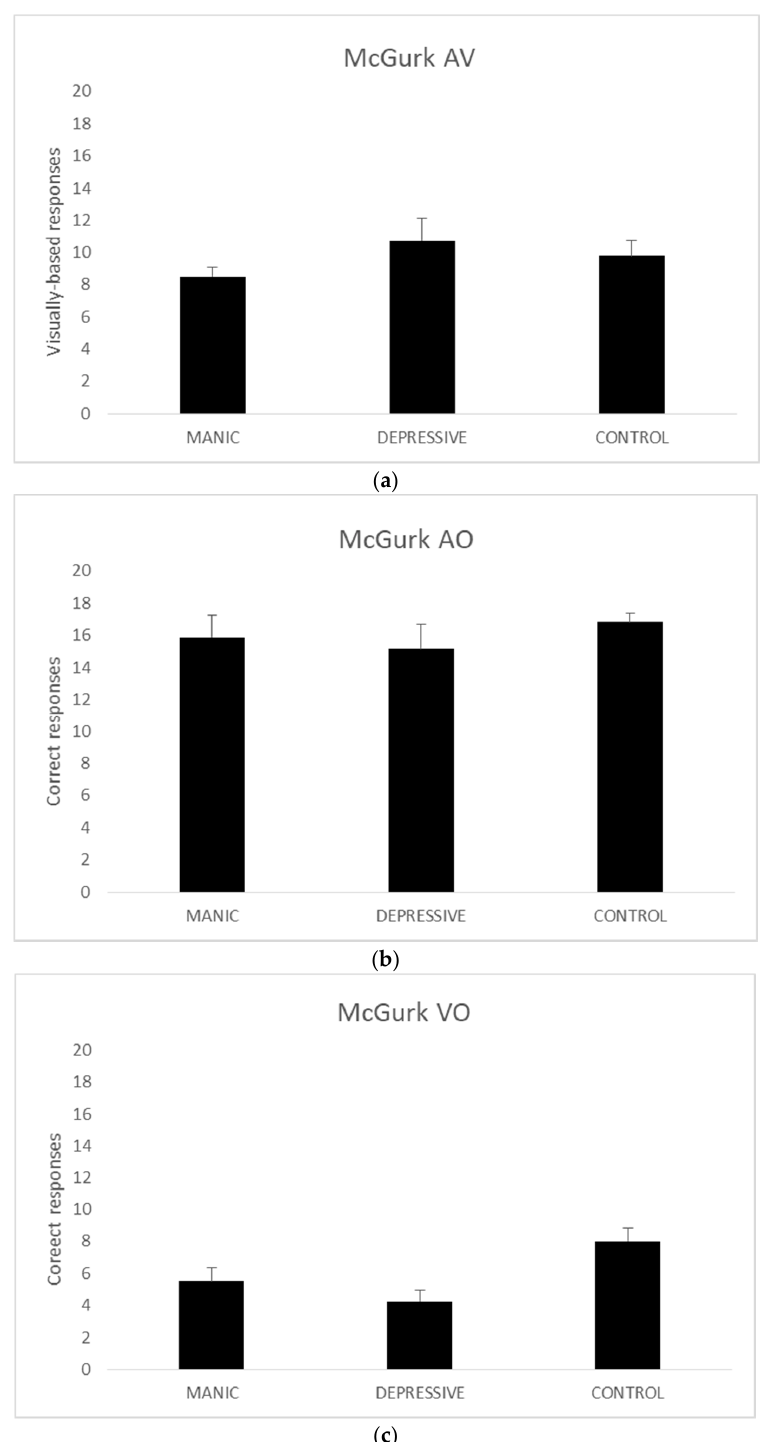
Figure 2. The mean scores of auditory–visual (AV) ( a ), auditory-only (AO) ( b ), and visual-only (VO) ( c ) scores obtained from the manic and depressive episode bipolar subgroups and the control group. Error bars represent the standard error of the mean.